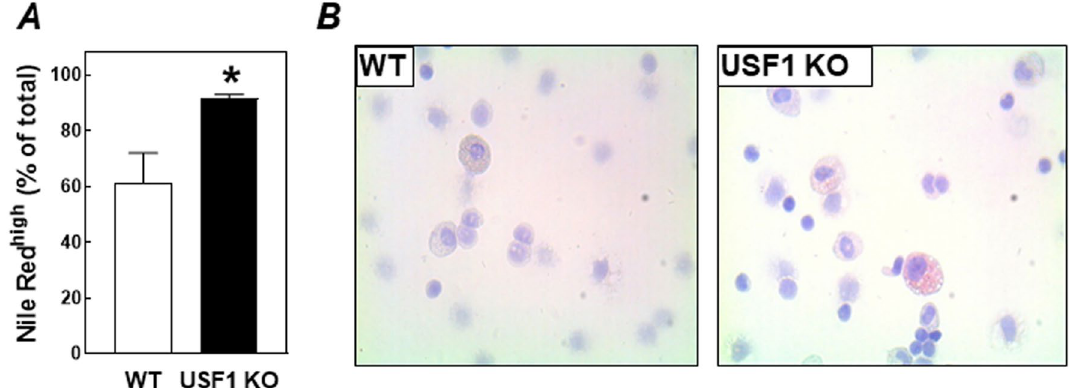
Figure 3. ( A ) The percentage of peritoneal leukocytes isolated from LDL receptor knockout mice transplanted with bone marrow from USF1 knockout (USF1 KO) mice or their wild-type (WT) littermate controls that stained positive using Nile Red for the presence of neutral lipid accumulation. Data represent the means ± SEM of 6 randomly chosen WT and USF1 KO bone marrow recipients. * P < 0.05 versus WT. ( B ) Representative images of Oil red O-stained cytospins of isolated peritoneal